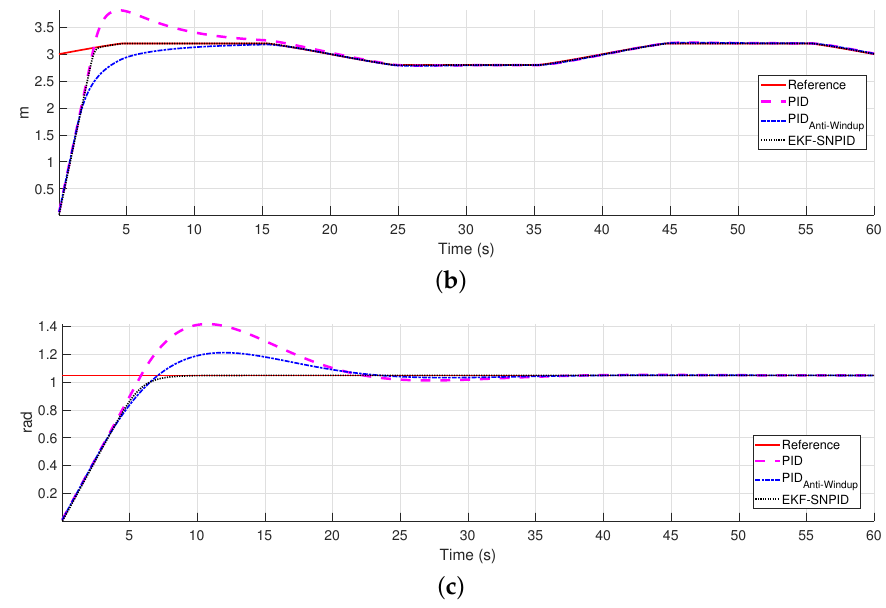
Figure 16. System response for the trapezoidal trajectory with offsets. ( a ) System response for x . ( b ) System response for y . ( c ) System response for θ .